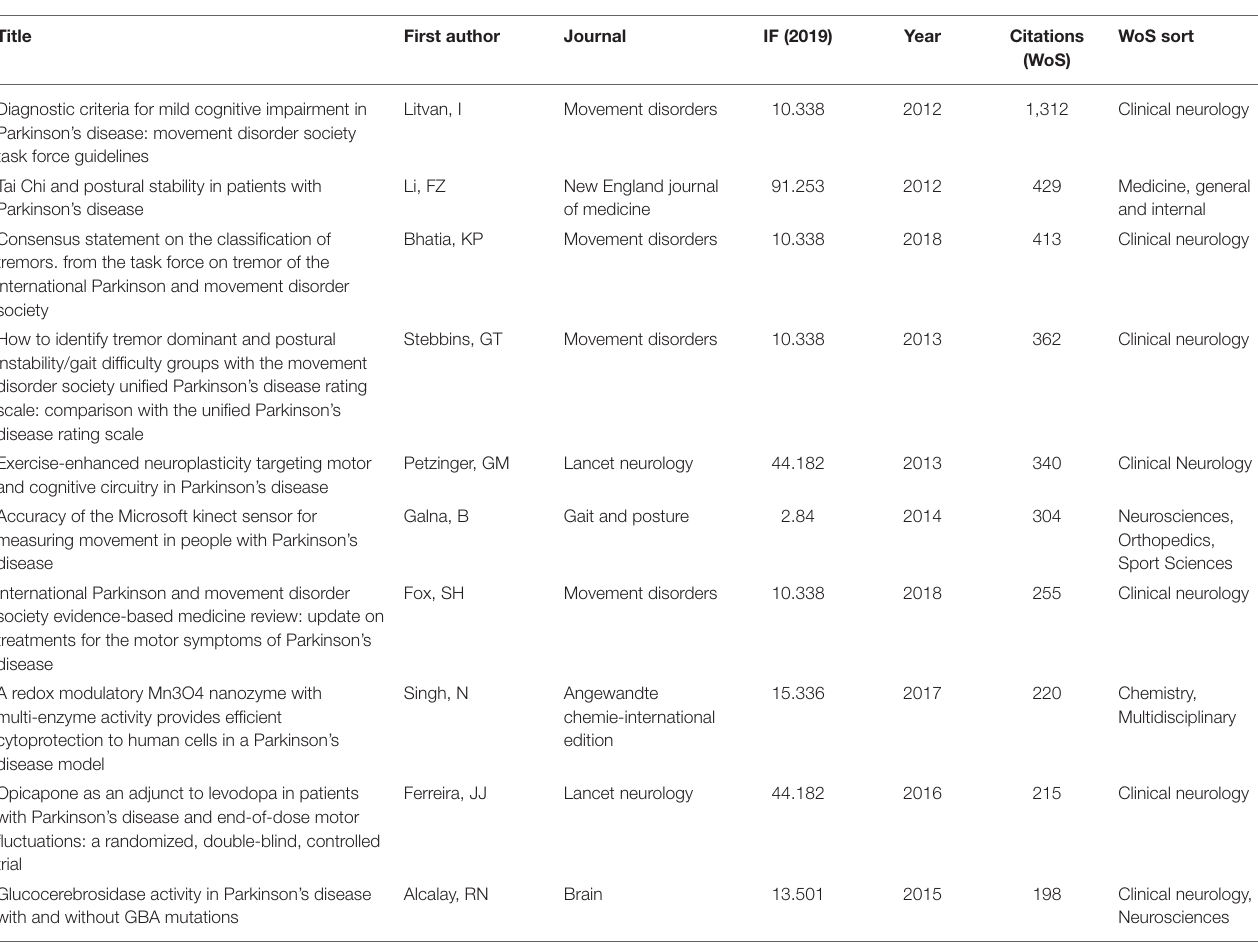
TABLE 3 | Top 10 most cited papers on exercise for